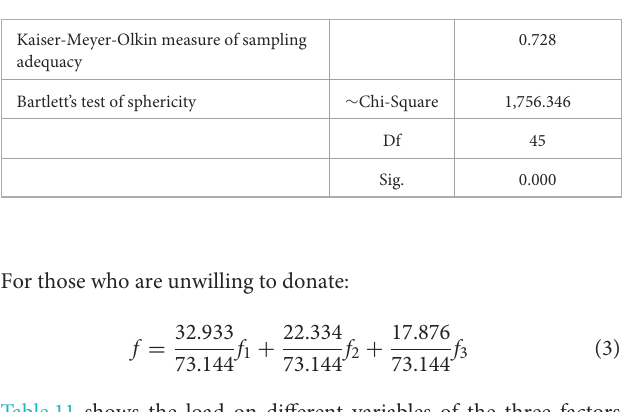
TABLE 8 KMO and Bartlett’s test (unwilling to donate